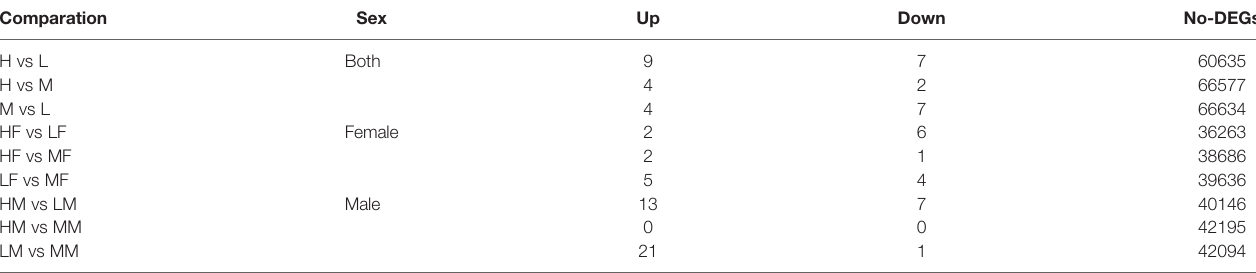
TABLE 2 | Pairwise comparisons of differentially expressed genes in the different sexes and different PUFA abundance groups of Strongylocentrotus intermedius . Comparation Sex Up